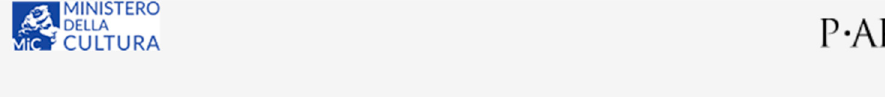
Figure 3. SyPEAH, monitoring lab: flow diagram in the WebAPP system.